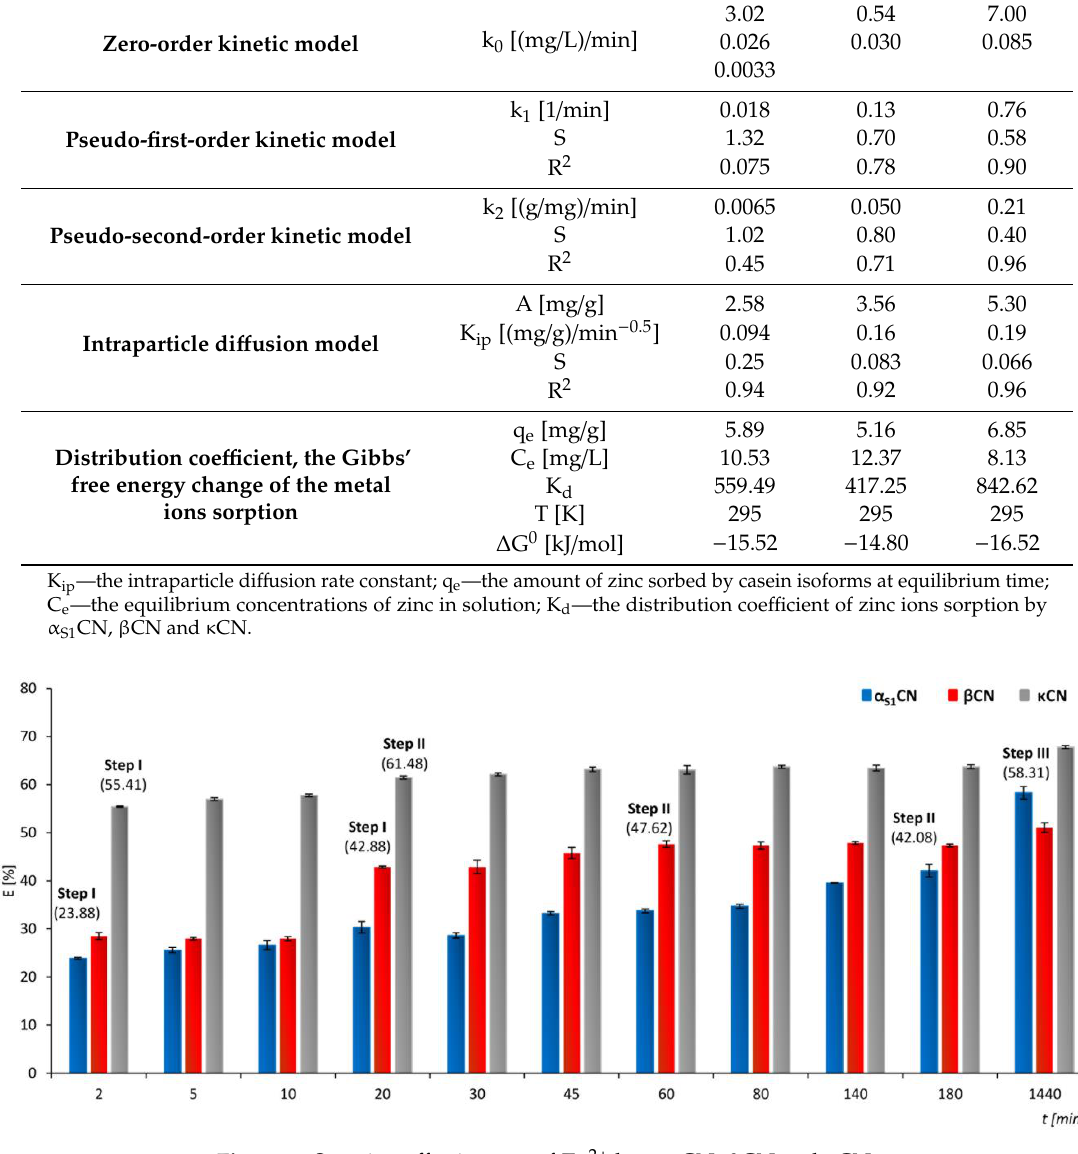
Figure 3. Sorption effectiveness of Zn 2+ by α S1 CN, βCN and κCN.